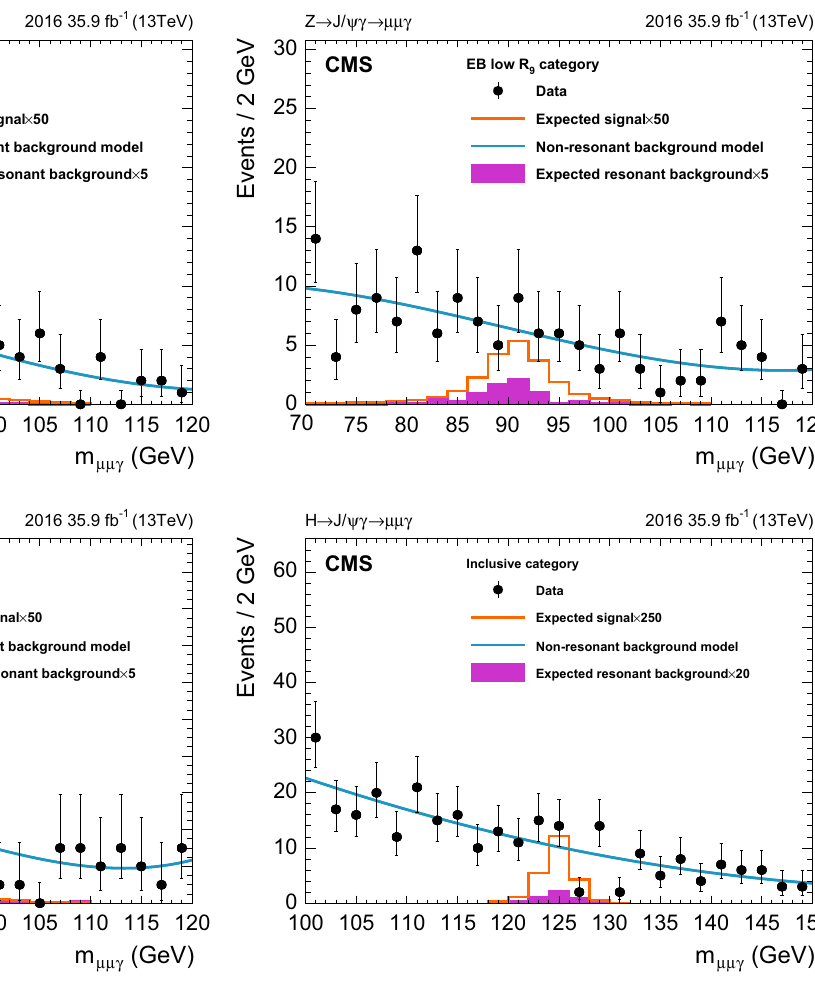
Fig. 7 Fits to nonresonant background using lowest-order unbiased functions to describe the three-body invariant mass m μμγ distributions observed in data for the Z → J /ψγ channel in the EB high R 9 category